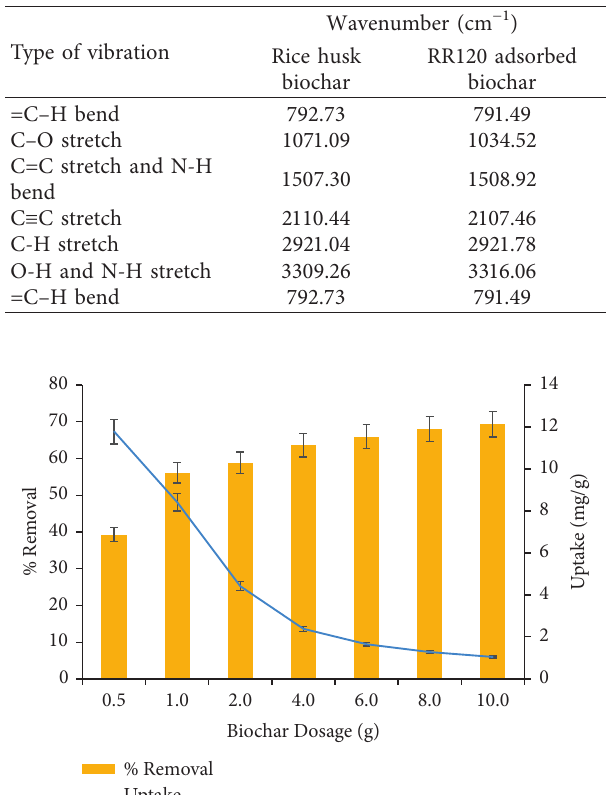
Table 1: FTIR spectra of raw rice husk biochar and dye adsorbed biochar.